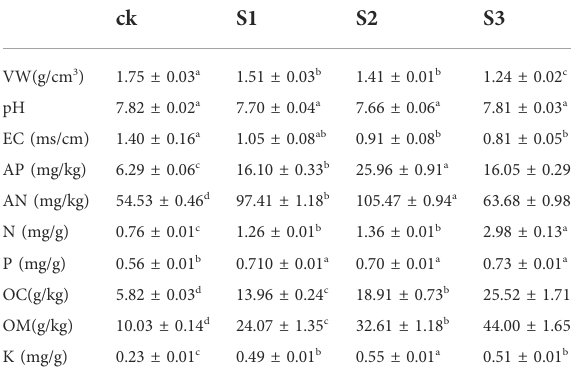
Data are means ± SD, of three replicates. Values within a column followed by different lowercase letters are signi fi cantly different ( p < 0.05). Organic carbon (OC), organic matter (OM), total nitrogen (N), available phosphorus (AP), alkaline nitrogen (AN), total potassium (K), total phosphorus (P), electrical conductivity (EC), fresh weight (FW), and volumetric weight (VW).